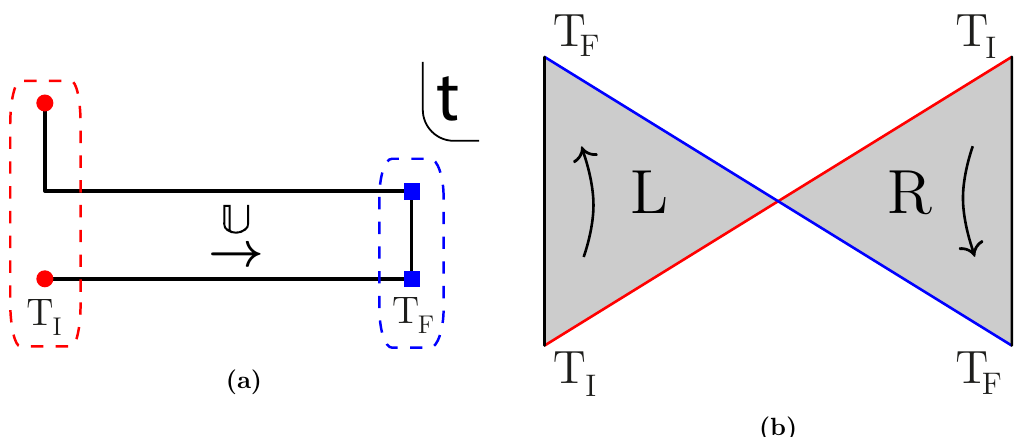
Figure 3 . (a) Schwinger-Keldysh path in the complex t -plane. The vertical lines set up the initial and (cid:12)nal states, while the horizontal lines represent the real time evolution of the TFD system. (b) Two-sided exterior regions of the AdS-BH showing the surfaces on which we insert the in/out-wave functions. The arrows depict the boost like character of the TFD